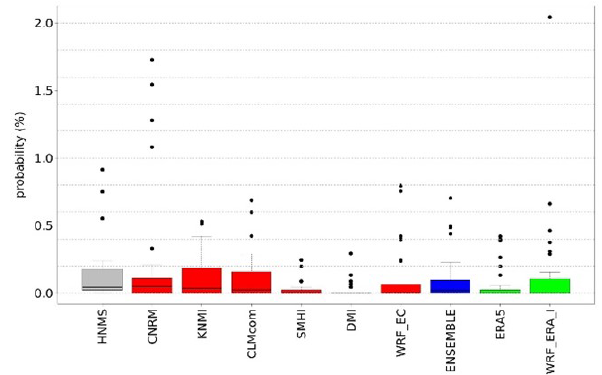
Figure 2. Box plot presenting RR20FD empirical method probabil- ities for observations and models.